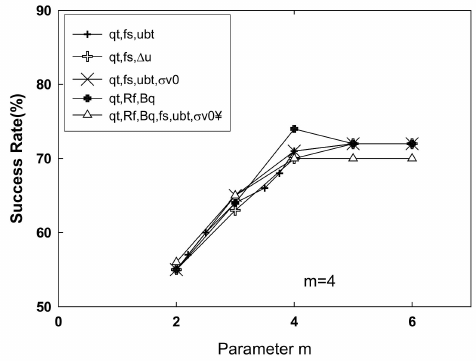
Figure 5. Change in success rate with respect to m value.